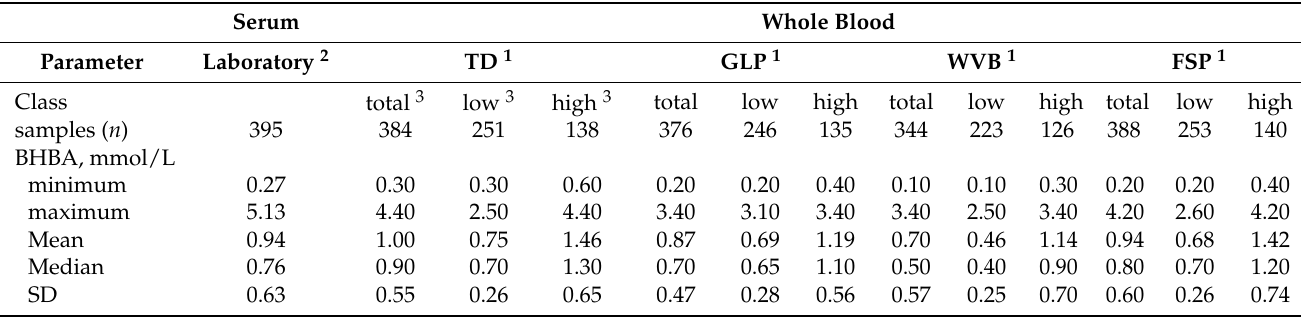
Table 1. Descriptive statistics of the β -hydroxybutyrate (BHBA) concentration analyzed in serum (laboratory) and whole blood (TD, GLP, WVB, FSP) taken from the coccygeal vessels of 100 post-partum Holstein-Friesian dairy cows (between day 5 and 38 after calving on test days 2, 4, 9, and 11 during the trial period), analyzed by